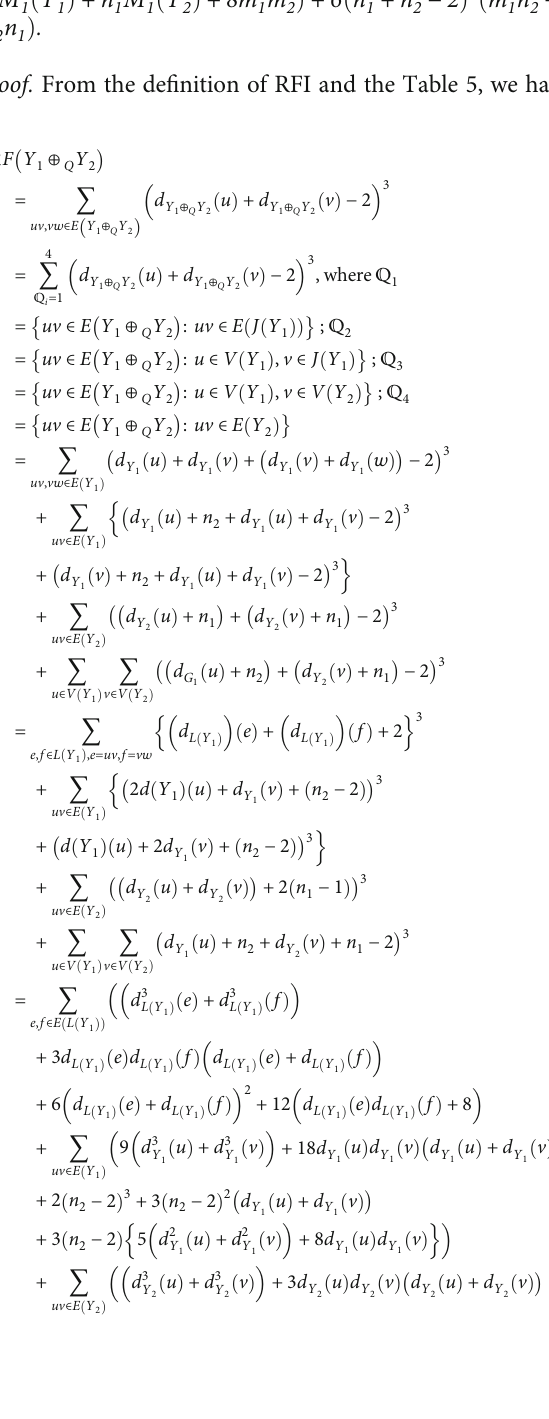
and P . 4 3 Table 5: The degree distribution of Y